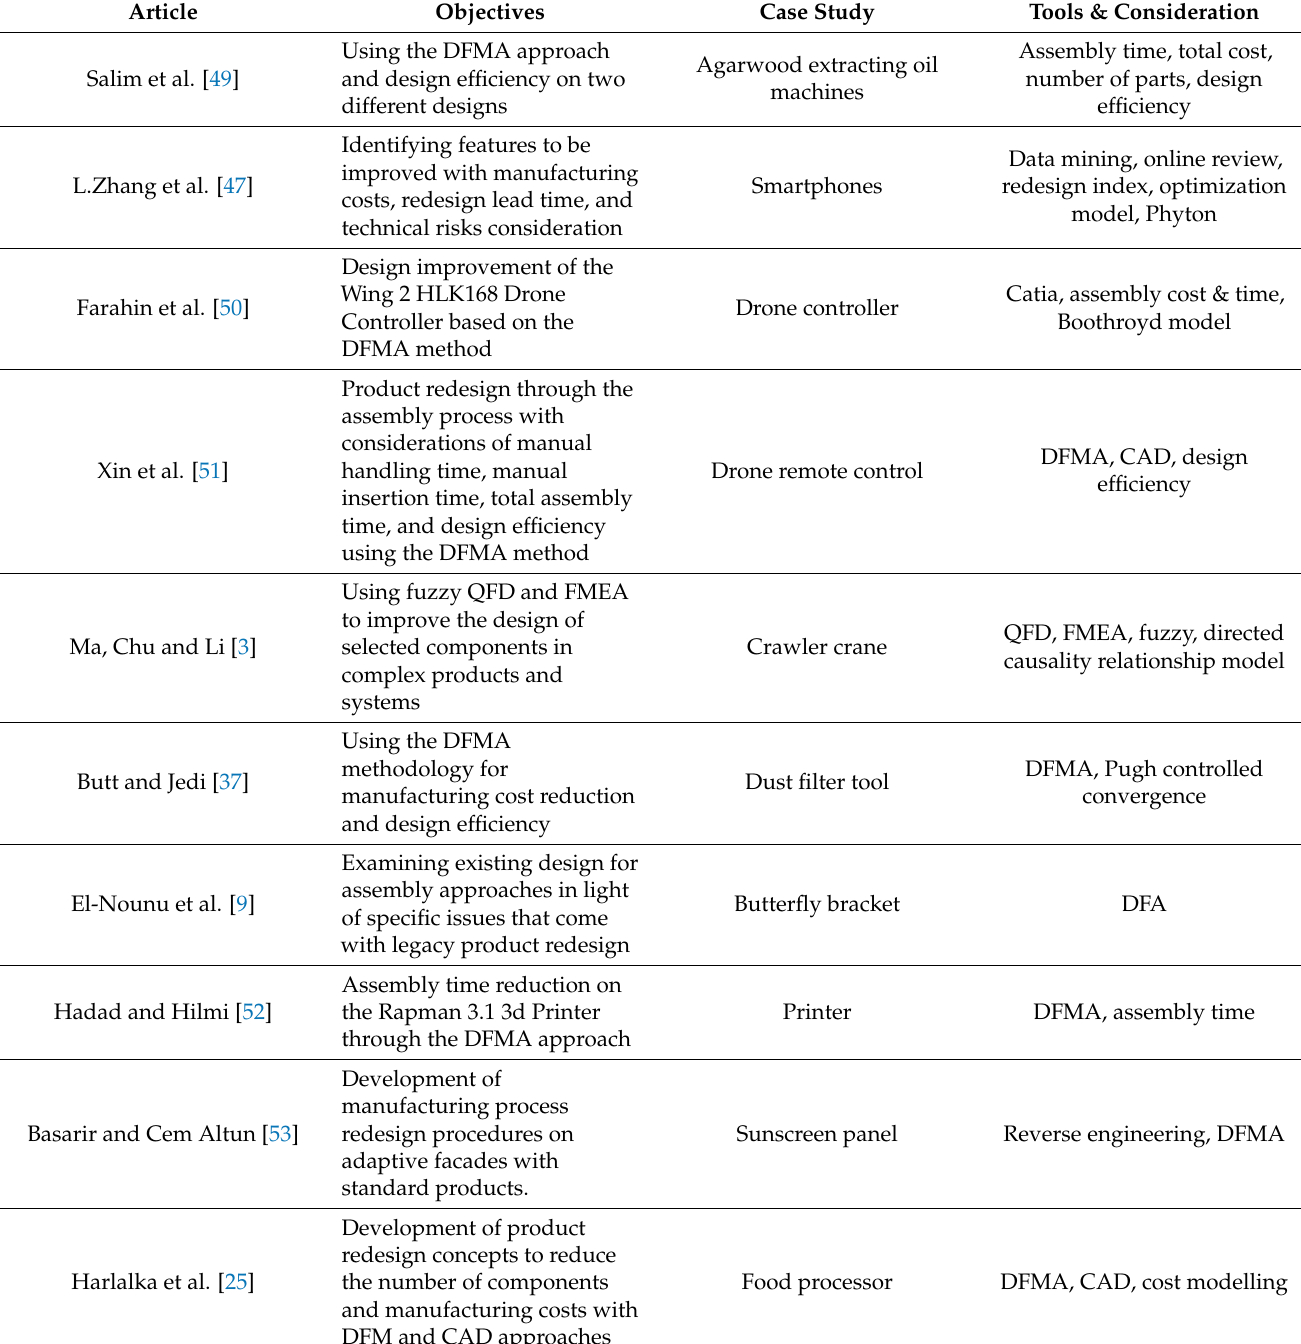
Table 3. Preliminary research in product